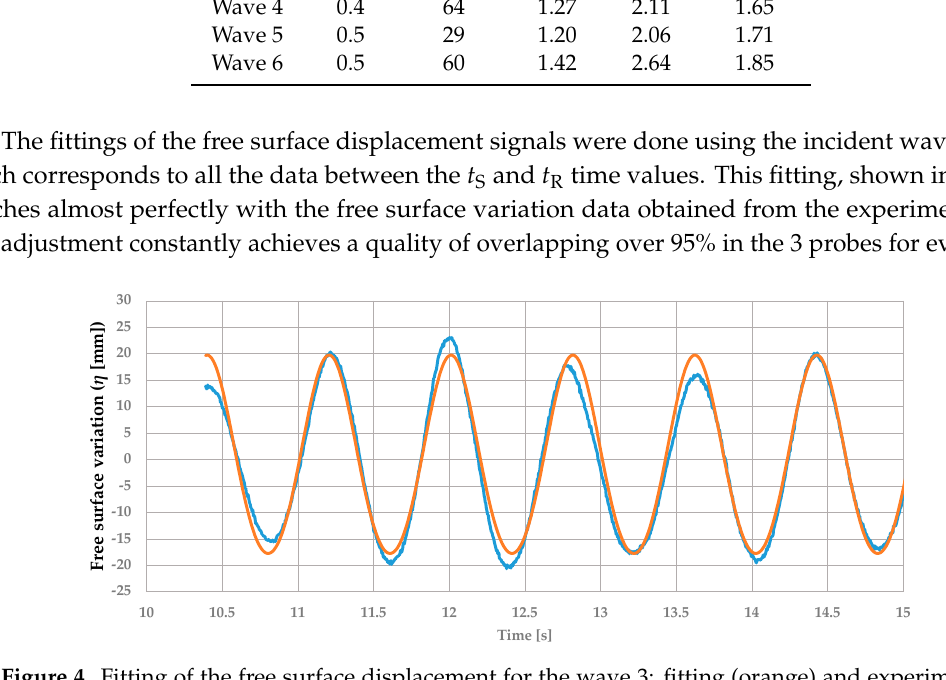
Figure 4. Fitting of the free surface displacement for the wave 3: fitting (orange) and experimental (blue) measured by the first probe of the EWF.